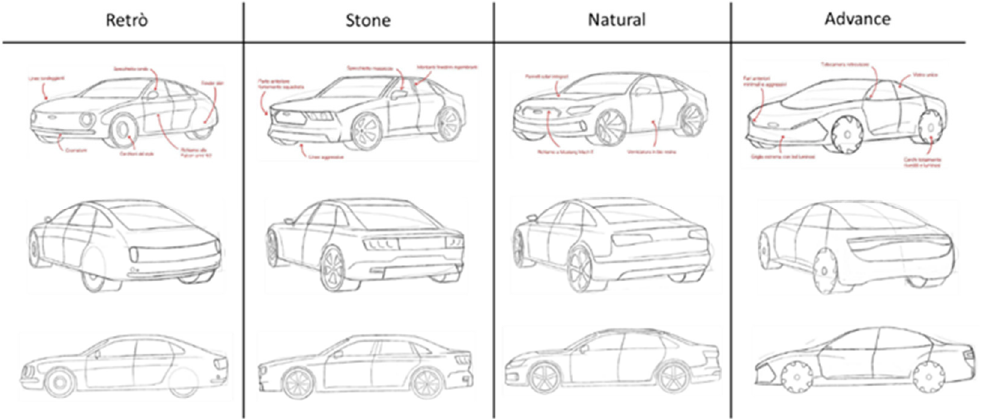
Figure 5. Different view sketches for the proposed car design in the four different styles.